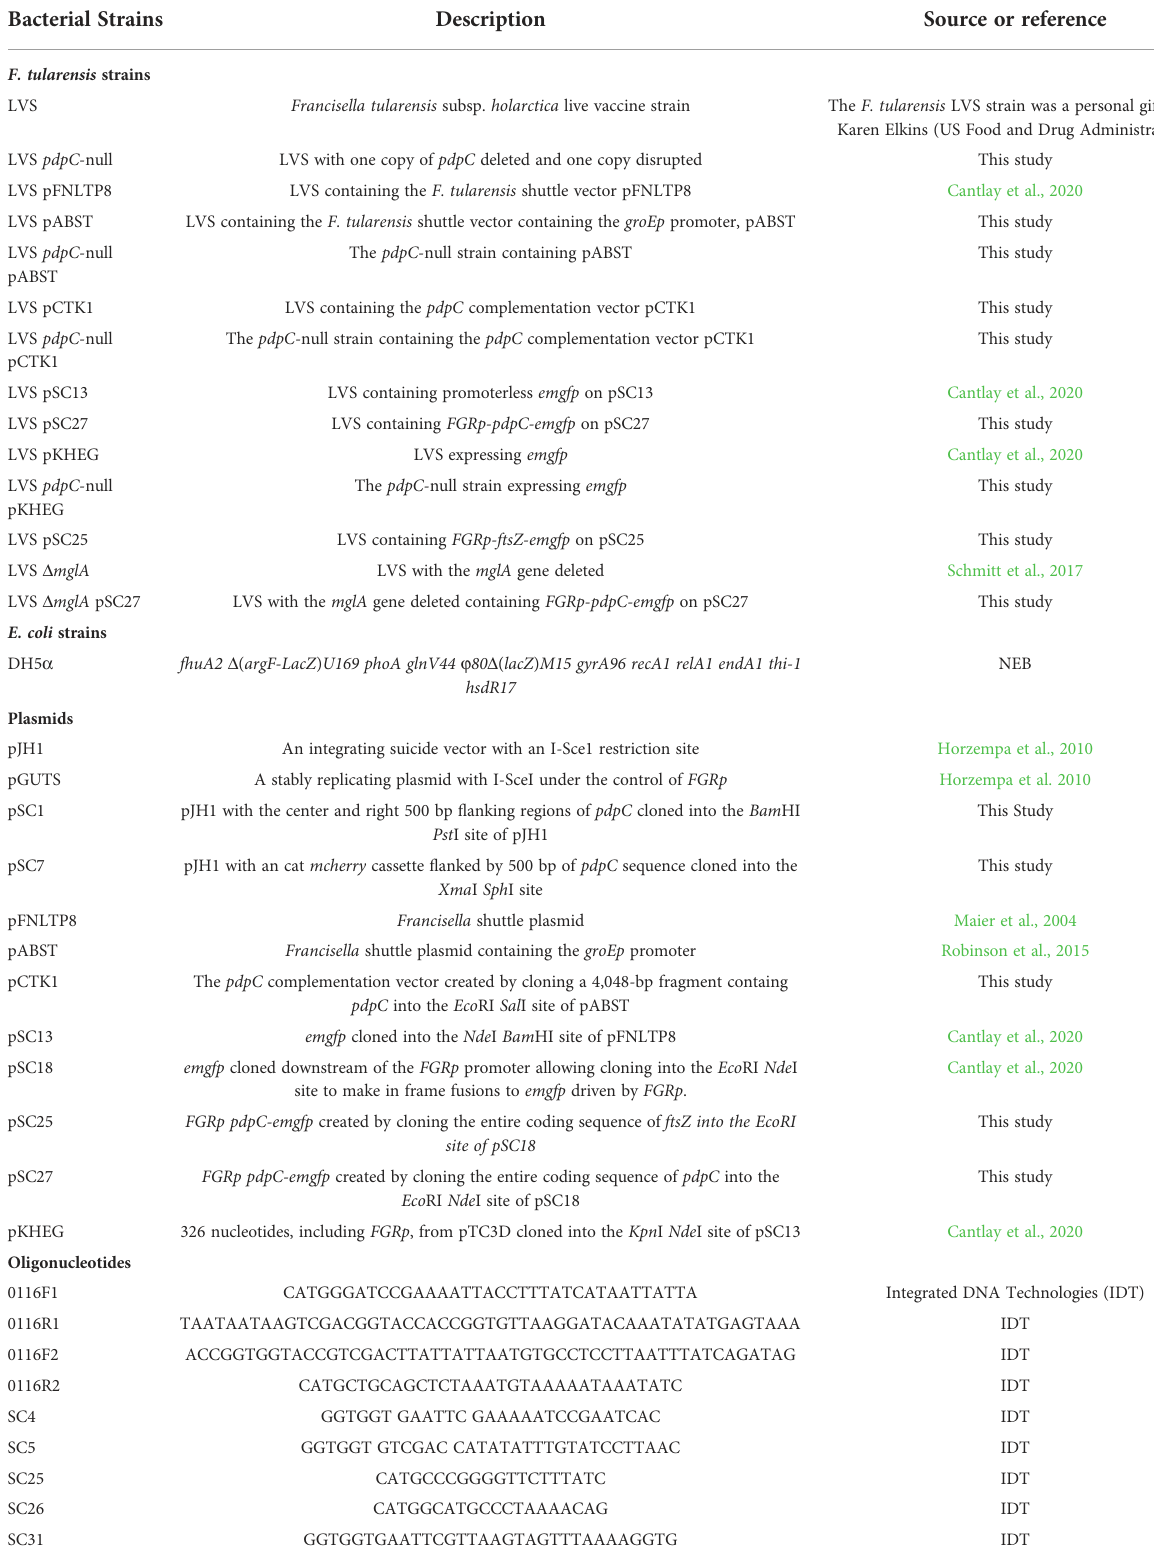
TABLE 1 Bacterial strains, plasmids and oligonucleotides used in this study. Bacterial